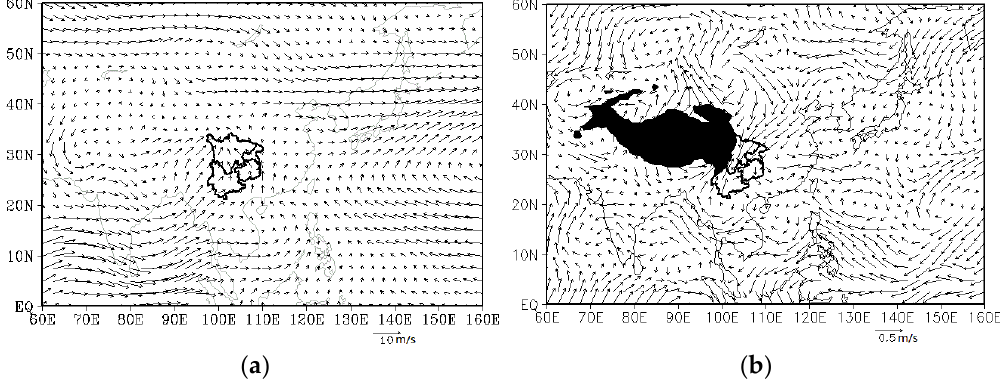
Figure 8. The 850 hPa wind field of rainstorms and floods in high-value years ( a ), the correlation coefficient ( b ) of rainstorms and floods and 850 hPa wind field in the summer half-year of 1961 –